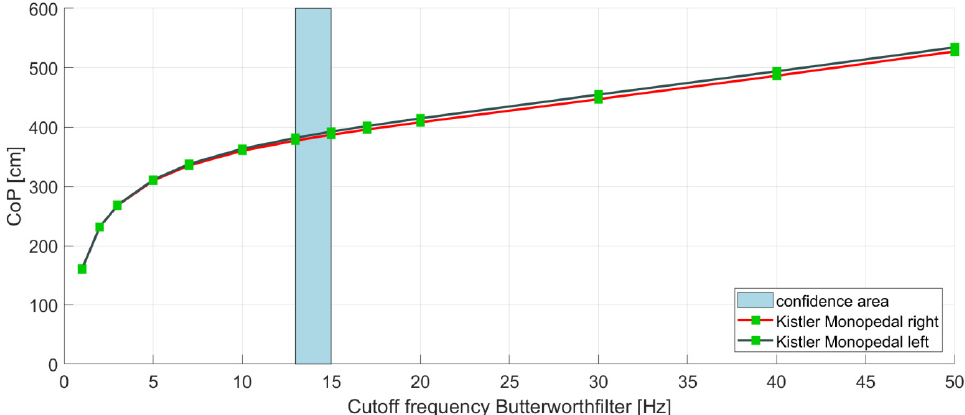
Figure 8. Result of the variation of different filter frequencies in the bipedal state for the measurement conditions of eyes open (red) and eyes closed (black).